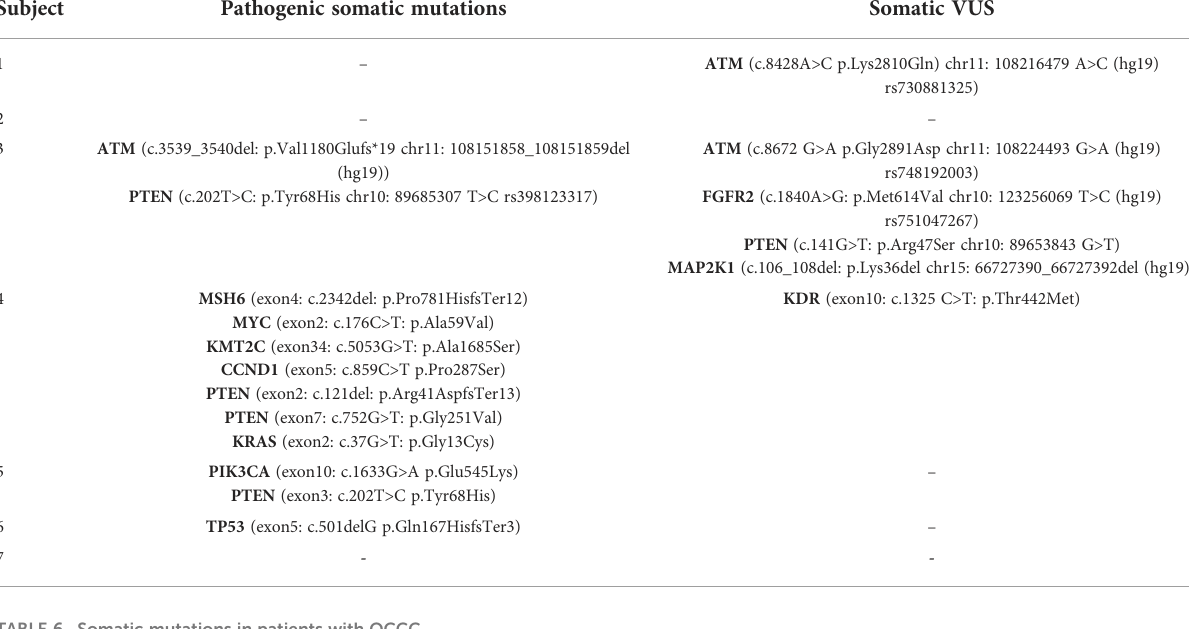
TABLE 5 Somatic mutations in patients with endometrioid (EC) ovarian carcinoma.